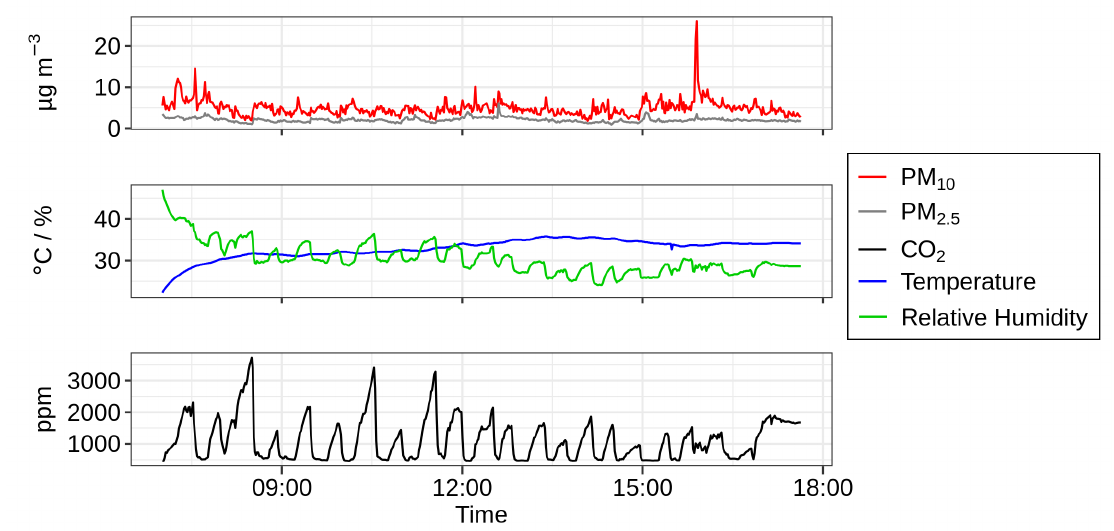
Figure 5. Time series plot of the exposure of a professional driver in a shuttle bus September 9 with the Air Filtration System (AFS) switched